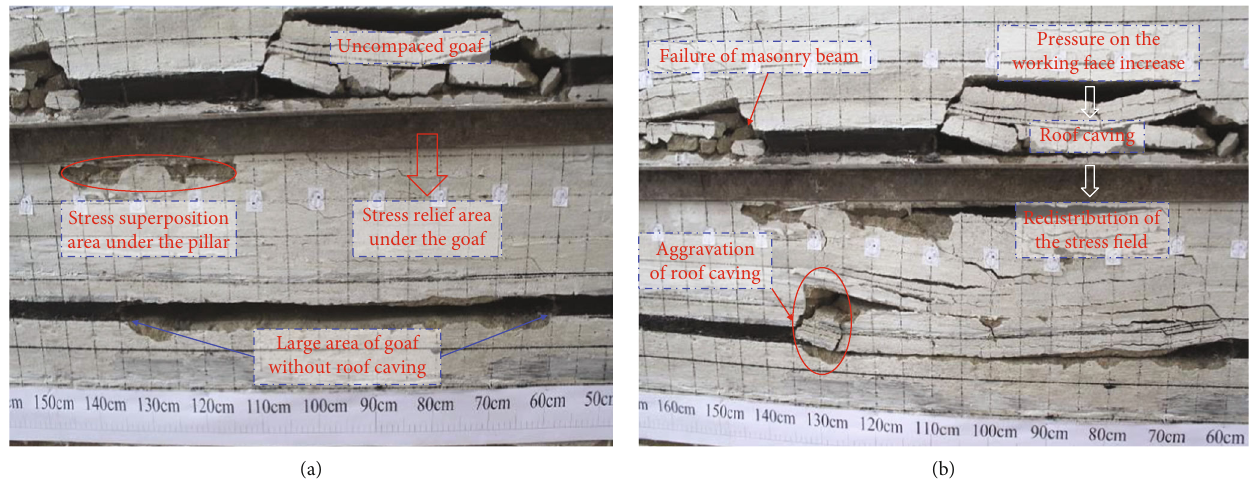
Figure 8: Illustration of the overburden pressure evolution after the 6-1 coal seam mining: (a) Before the fi rst weighting. (b) After the fi rst weighting.